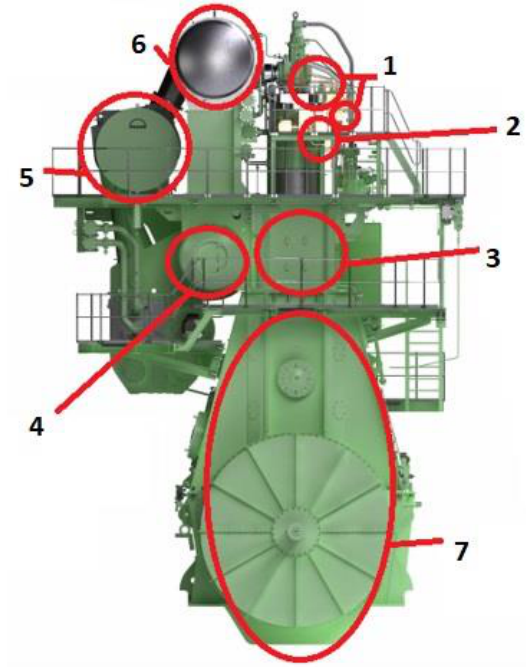
Figure 1. Components of a crosshead-type engine and its surroundings that can cause an explosion (modified based on Chybowski, 2022): 1 — fuel injection system, 2 — starting air system, 3 — un- sion (modified based on Chybowski, 2022): 1—fuel injection system, 2—starting air system, 3— derpiston spaces, 4 — scavenge space, 5 — turbocharger, 6 — exhaust manifold, 7 — crankcase. underpiston spaces, 4—scavenge space, 5—turbocharger, 6—exhaust manifold,